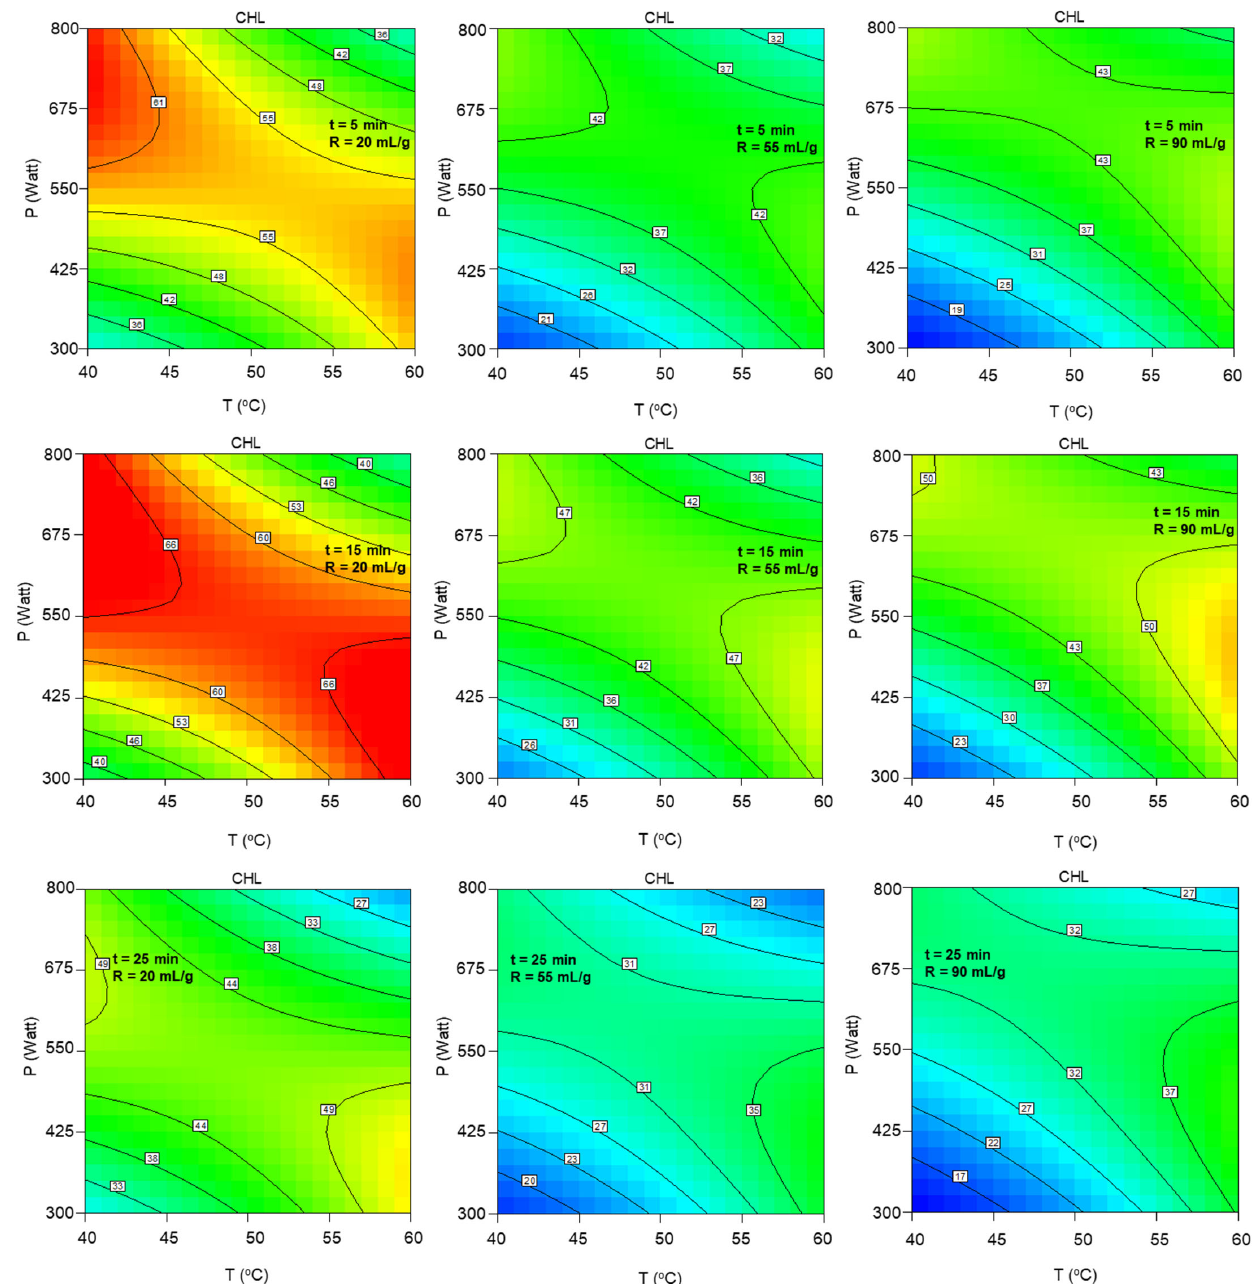
Figure A2. Contour plots of extract’s total chlorophyll content as a function of extraction temperature and microwave power at the low, central and high levels of extraction duration and solvent-to- biomass ratios.